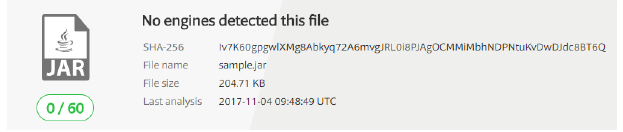
Figure 9. Analysis by virustotal.com.